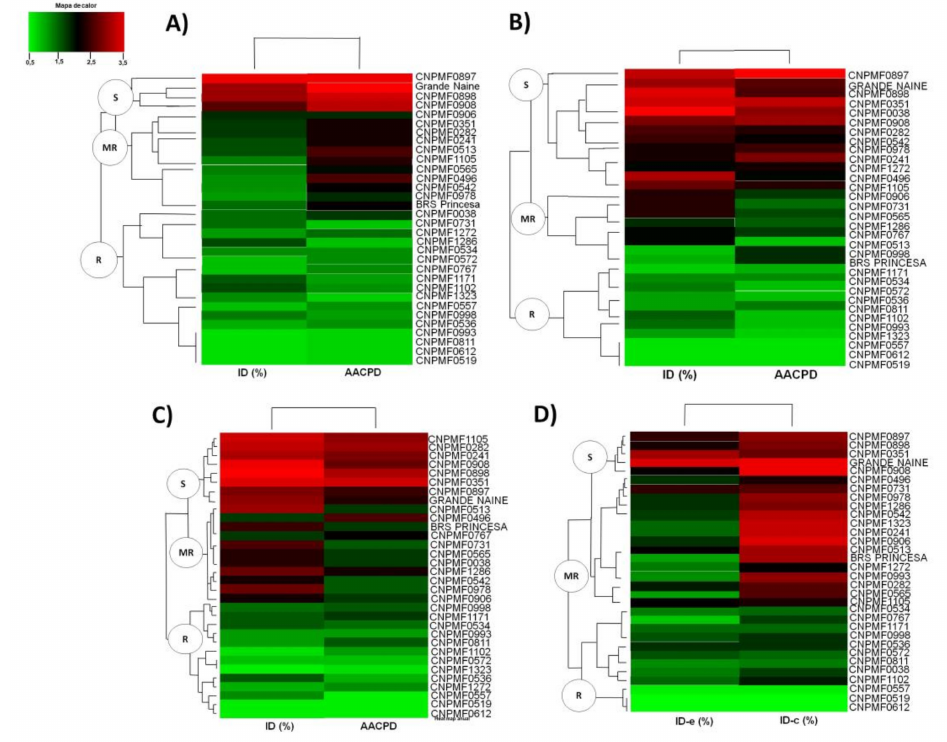
Figure 1. Clustering of banana genotypes for resistance to black Sigatoka from the disease severity index (DI) and area under the disease progress curve (AUDPC), estimated by evaluating the symp- toms of four n ◦ 3 leaves: ( A ) evaluation in the summer, ( B ) winter, ( C ) year, and ( D ) classical. DI-e: bunch emission DI; DI-h: bunch harvest DI. S: susceptible, MR: moderately resistant, R: resistant. Embrapa